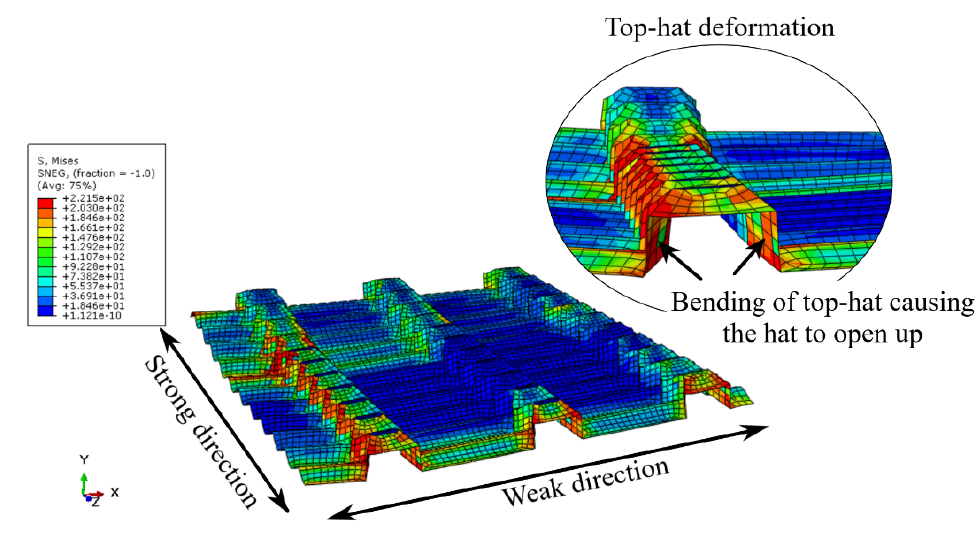
Figure 15. Failure of CTH deck type.